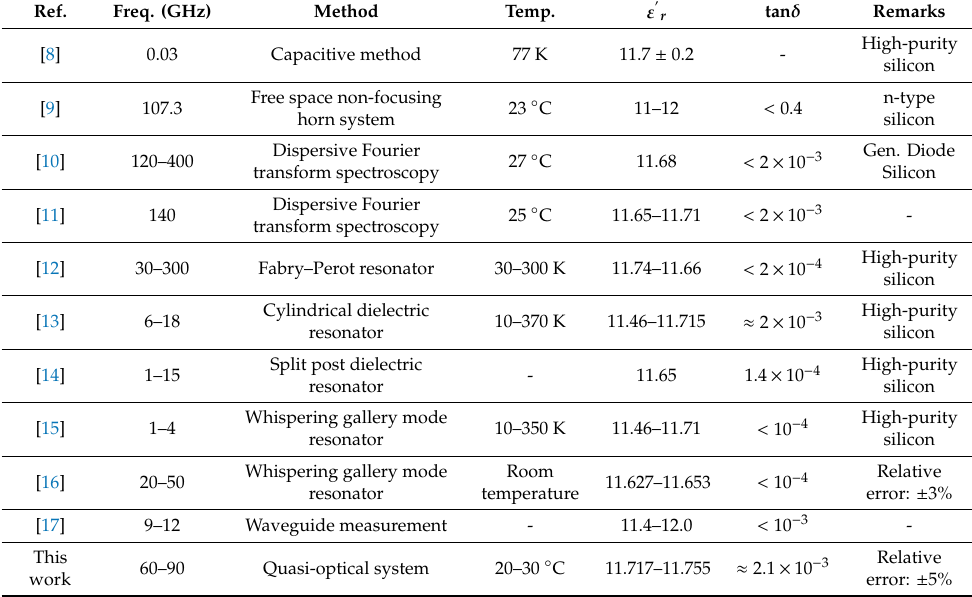
Table 2. A comparison of the measured permittivity of undoped